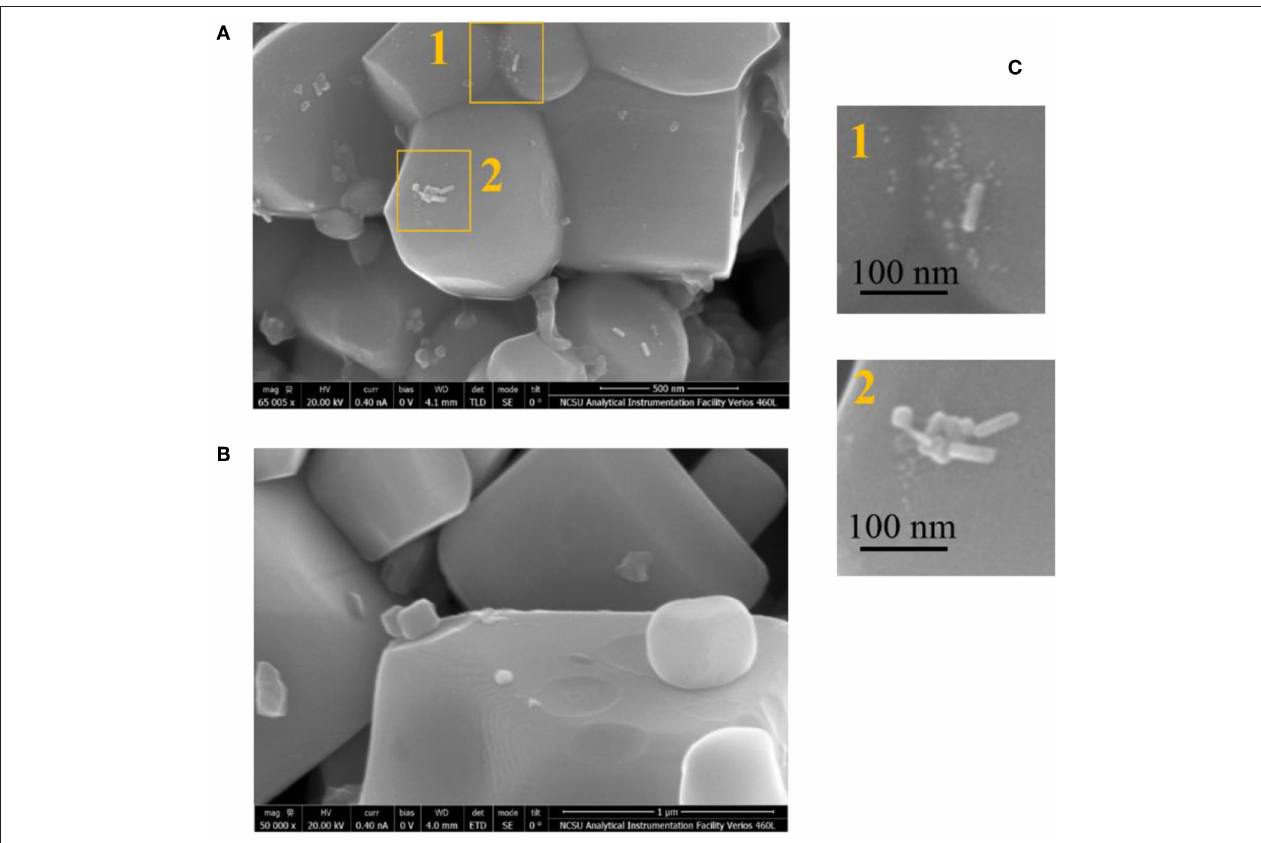
FIGURE 10 | SEM images of PbTiO 3 particles impregnated with and without AuNRs ( A,B , respectively; Scale bar: 1 µ m). The insets, 1 and 2 in (C) , show higher magnification SEM images of the PbTiO 3 surfaces after the photochemical reduction of Pt driven by light excitation of the localized SPR of the AuNRs and hot carrier injection. The Pt islands are confirmed by EDS scanning and are visible as white dots near the deposited AuNRs to within ∼ 100nm on the surfaces. Figure adapted from Ortiz et al. (2018). Copyright 2018 American Chemical